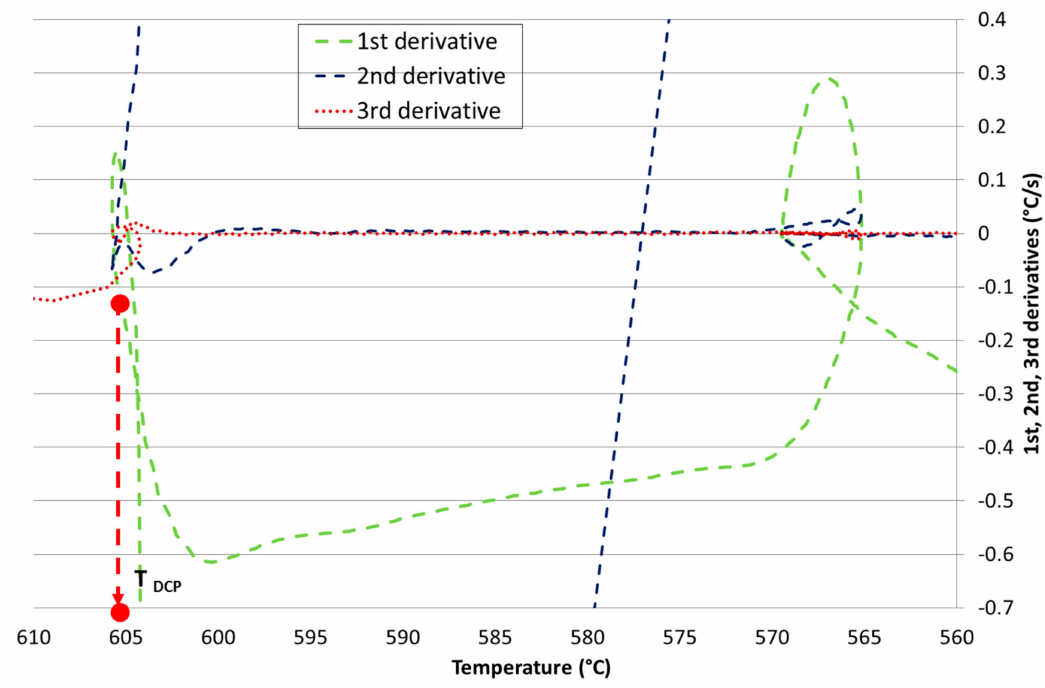
Figure 3. Method 3: dT/dt curve vs. T, with the DCP point in the